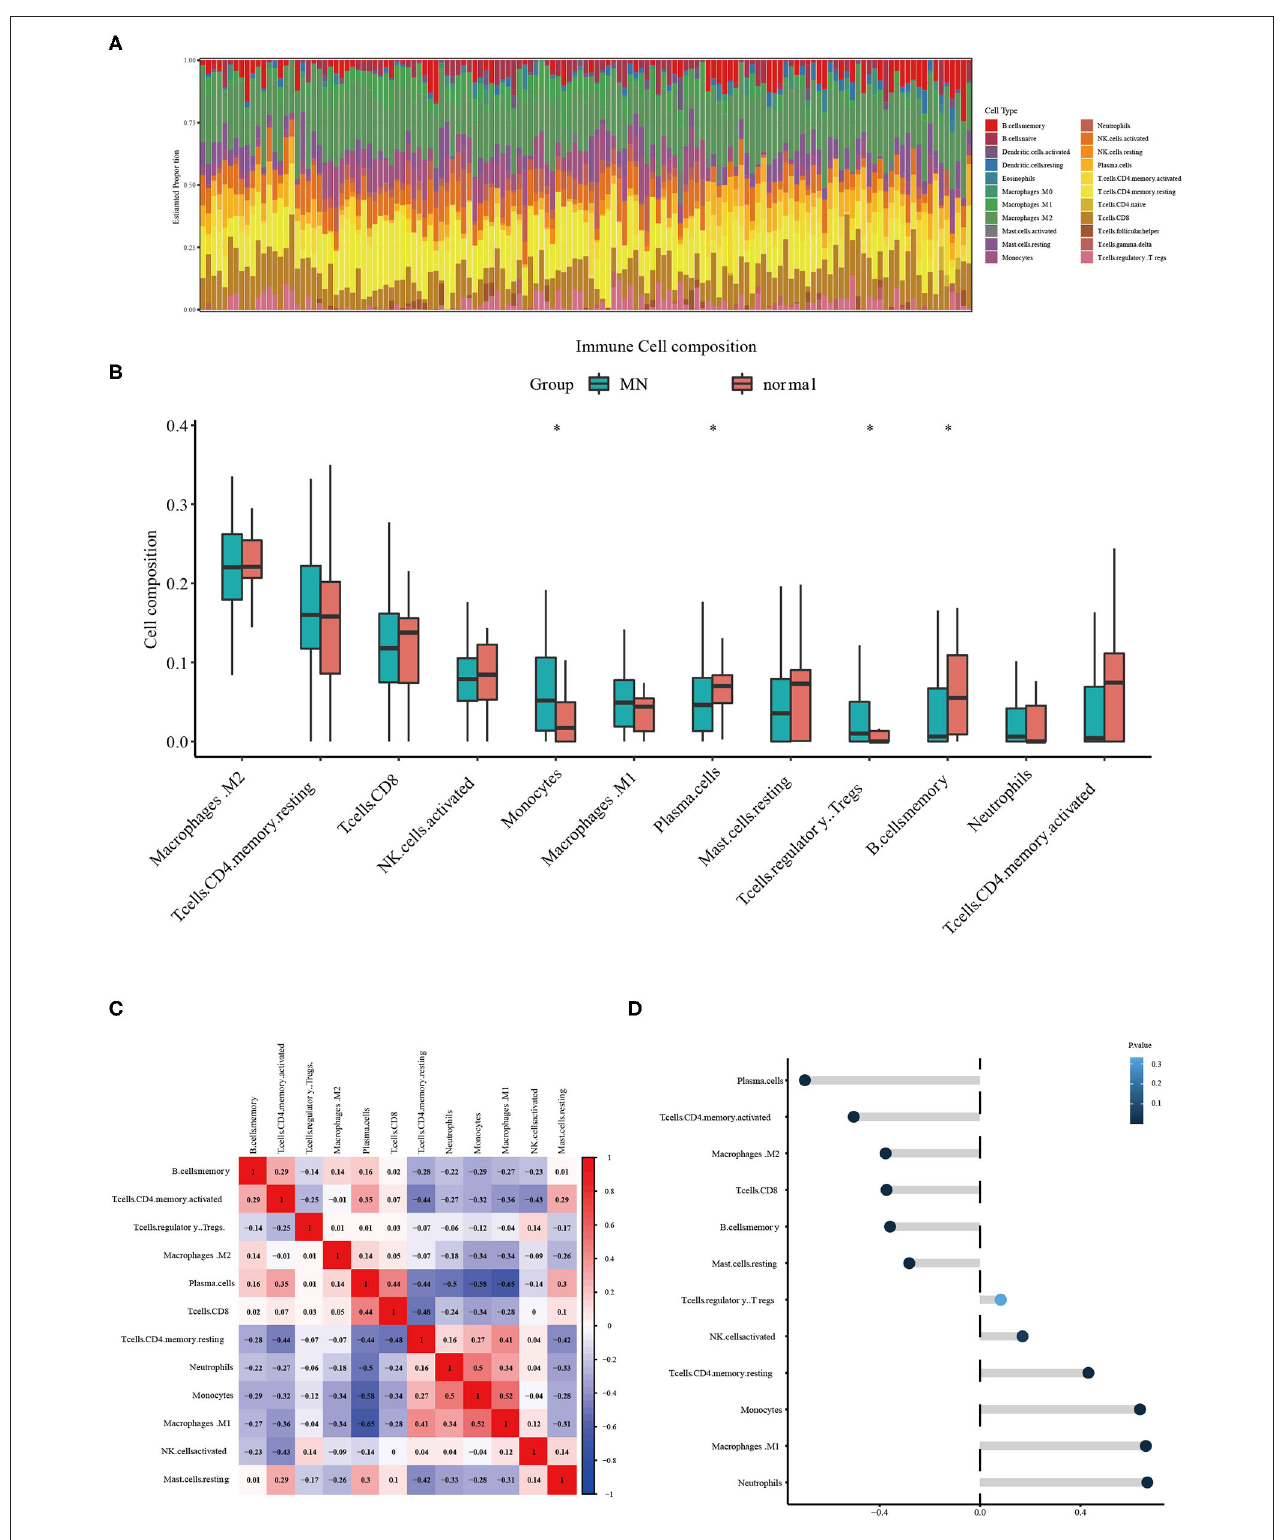
FIGURE 4 | (A) Estimated proportion of immune cells in each sample. (B) Different immune cell infiltration between MN and normal samples. The symbol * represents a P -value < 0.05. (C) Correlation between different infiltrated immune cells. (D) ETS2 Correlation upon different immune cell infiltrations.